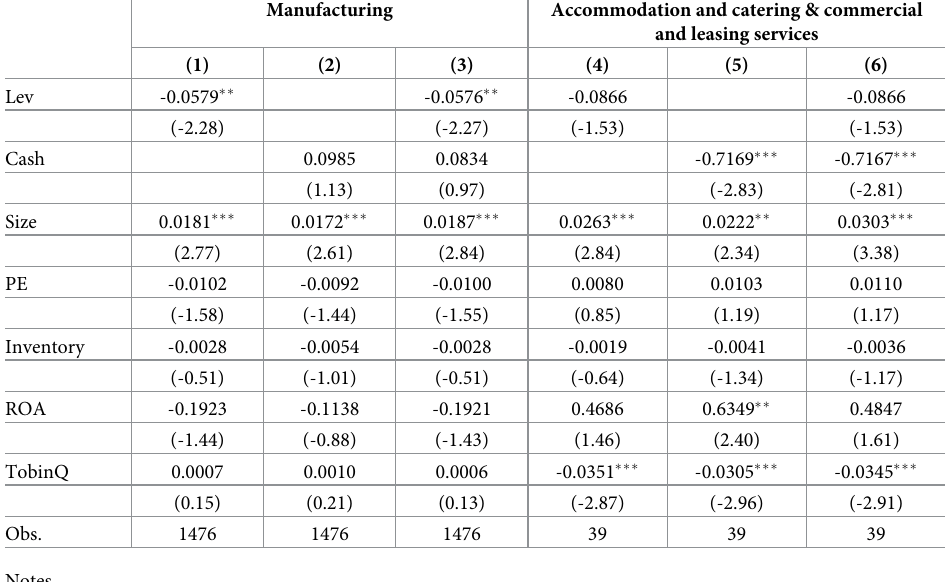
Table 8. Subsample regression results: Manufacturing subsample and service